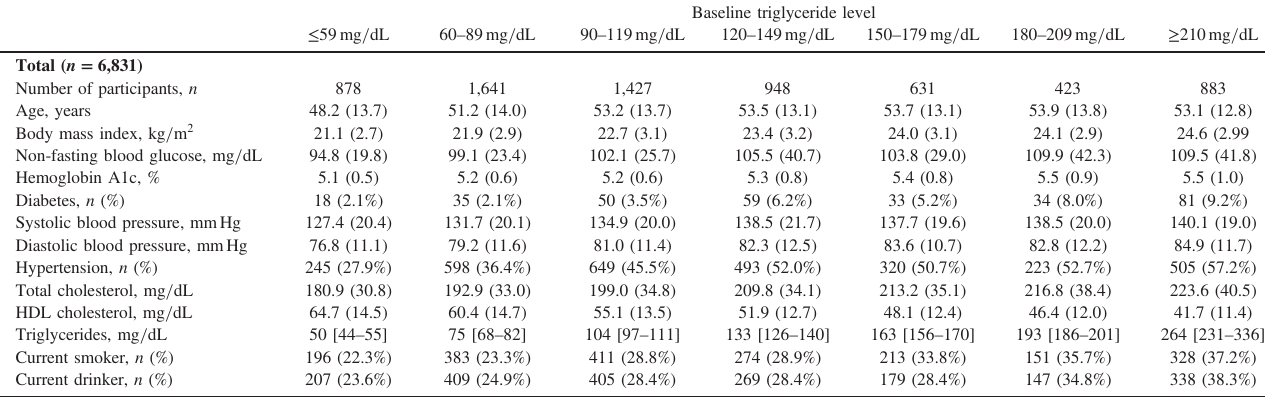
Table 2. Characteristics of study participants according to non-fasting triglyceride category at the baseline survey Baseline triglyceride level ≤ 59mg =